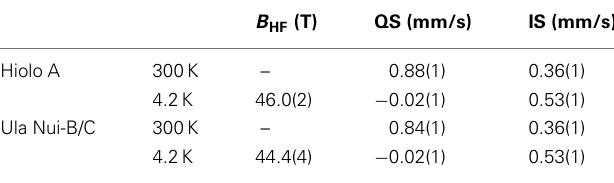
Table 5 | Magnetic hyperfine parameters fitted at room temperature and 4.2K.